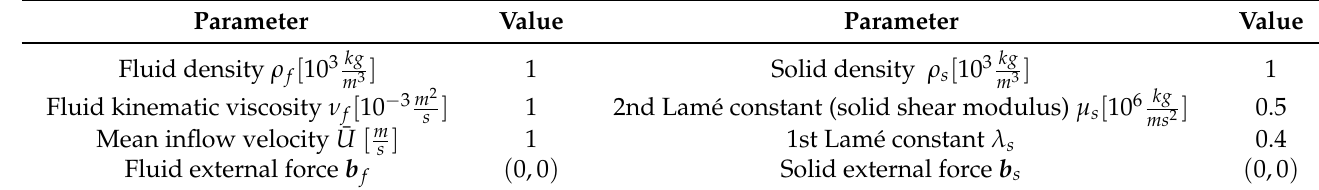
Table 1. Values of the physical constants of the fluid and of the solid.